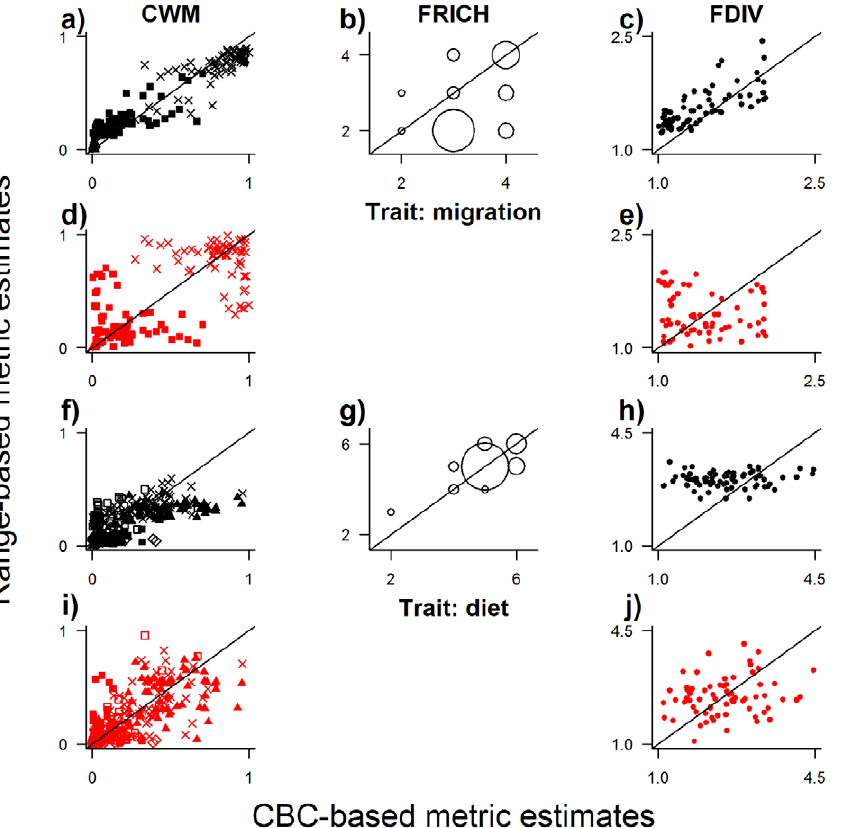
Figure 4. Correlation between distribution-based and CBC-based values of community composition metrics based on categorical traits. For each of the two categorical traits considered – migratory behaviour and diet – maps were generated of community-weighted mean trait value (CWM; a, d, f, i), functional richness (FRICH; b, g) and functional divergence (FDIV; c, e, h, j). For the categorical traits, community-weighted mean was calculated as the proportion of birds in each of the trait classes. Observed values were calculated from recorded abundances at 68 evaluation Christmas Bird Count (CBC) sites. Distribution-based estimates of the metrics were generated using four methods, with the best two shown here, as in Fig. 3. Lines represent y=x. Full results for all four methods are presented in Table 1.